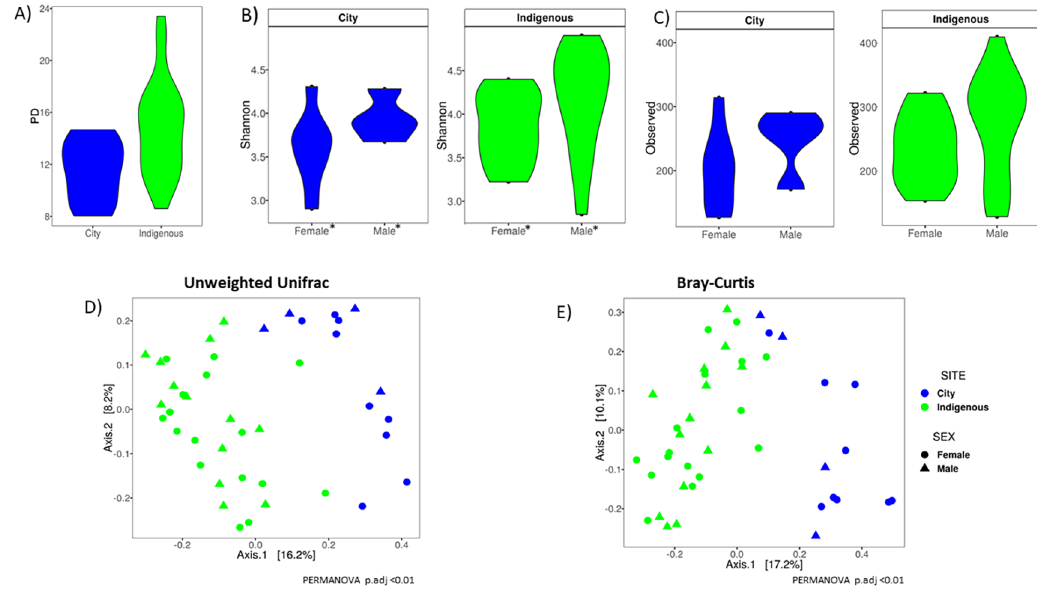
Figure 3. Alpha diversity indexes and Beta ordinations of children GM by population and sex. Figure 2. This is a figure, Schemes follow the same formatting. If there are multiple panels, they should The violin plot with median of ( A ) Faith’s phylogenetic diversity (PD) index by population; ( B ) Shannon be listed as: ( a ) Description of what is contained in the first panel. ( b ) Description of what is contained index; ( C ) Observed ASV’s. * corresponds to significant di ff erences ( p < 0.05); ( D ) Corresponds to in the second panel. Figures should be placed in the main text near to the first time they are cited. A Unweighted Unifrac; ( E ) Corresponds to the Bray–Curtis GM children analysis. For M é xico City (City) caption on a single line should be centered. and indigenous (Me´phaa) communities, blue and green were used, respectively. Di ff erences were statistically significant in the PERMANOVA test at a level of p < 0.01 only for location, but not for the gender of the child in both distance metrics ( D , E Table 1. This is a table caption. Tables should be placed in the main text near to the first time they are cited.